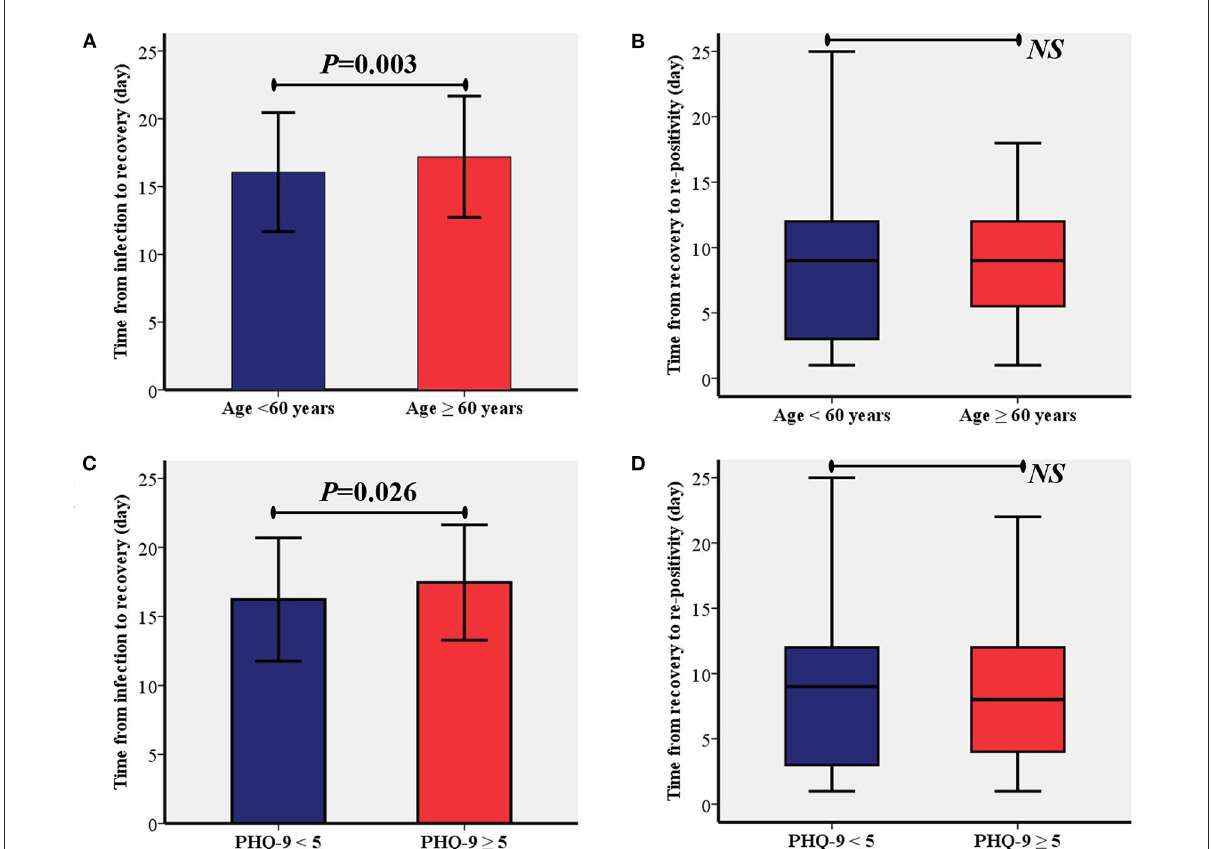
FIGURE2 Comparisons of time from the infection to recovery and time from recovery to re-positivity between different age group (A,B) and depression status (C,D) . PHQ-9, patient health questionnaire nine; NS, Not Significant.